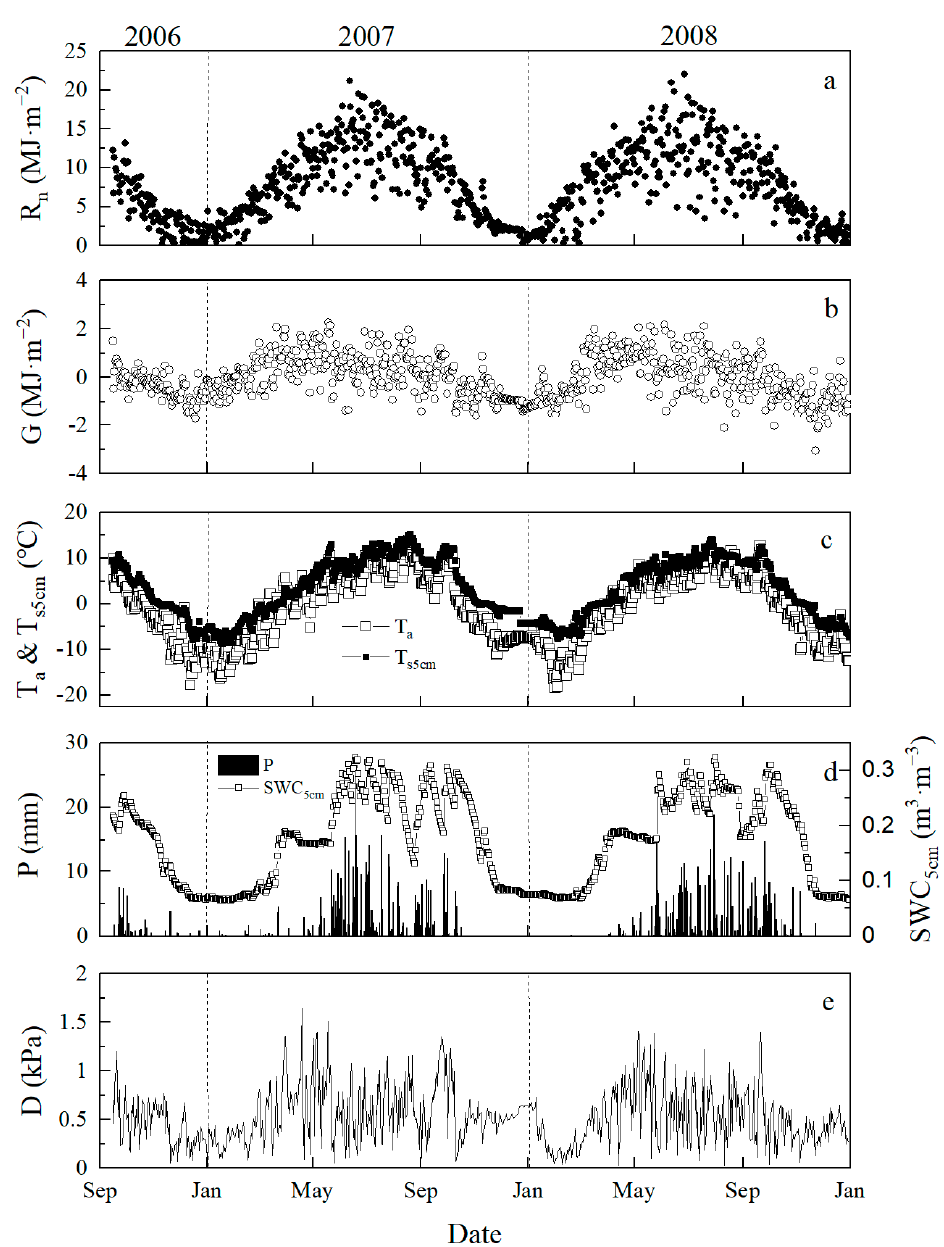
Figure 2. Annual variation of ( a ) net radiation ( R n ), ( b ) soil heat flux ( G ), ( c ) air temperature ( T a ) and 5 cm soil temperature ( T s5cm ), ( d ) precipitation ( P ) and 5 cm soil water content ( SWC 5cm ), and ( e ) vapor pressure deficit ( D ) in degraded alpine meadow from 2006 to 2008.